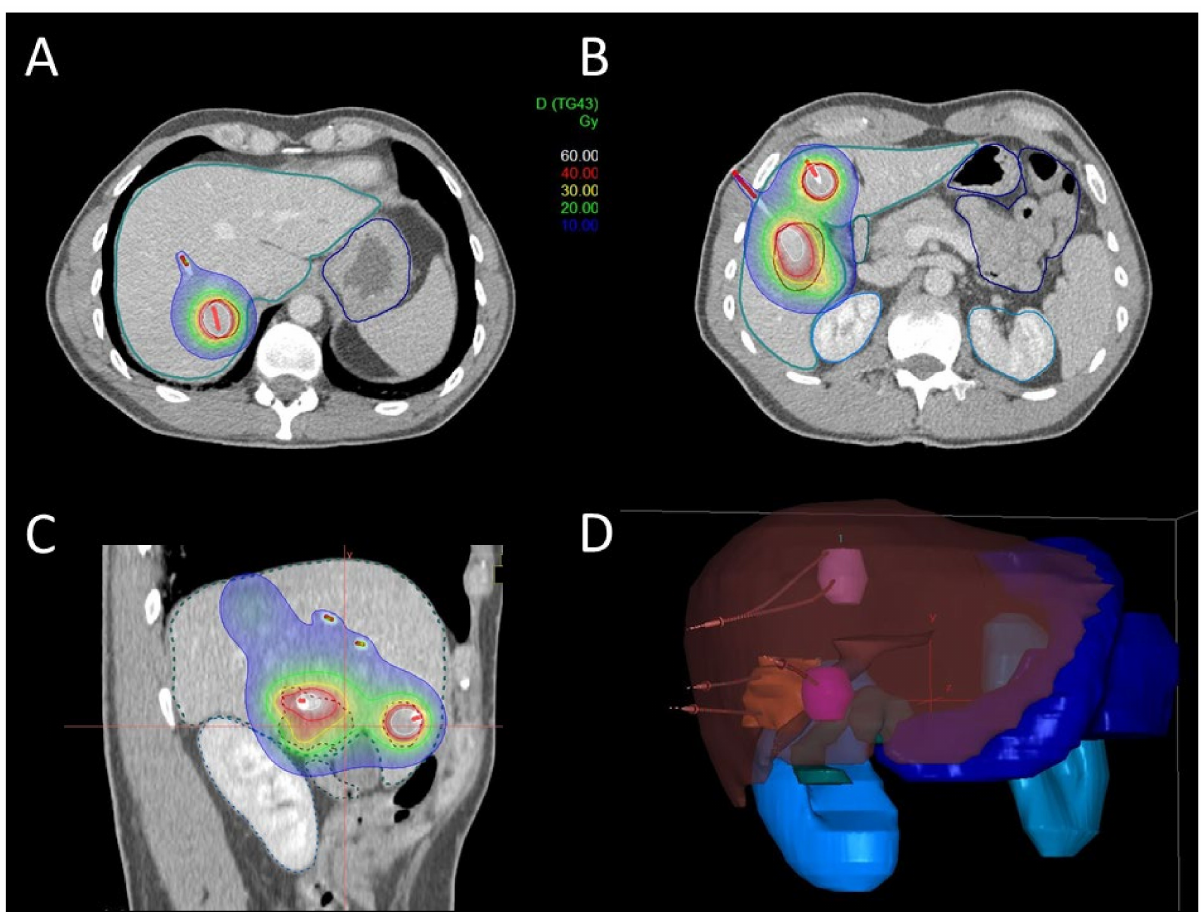
Figure 1. Patient example of interstitial brachytherapy in multiple lesions. ( A , B ) Axial views of multiple liver lesions in different liver segments; ( C ) sagittal view of multiple liver lesions; ( D ) reconstruction of liver volume with multiple lesions and multiple catheters in